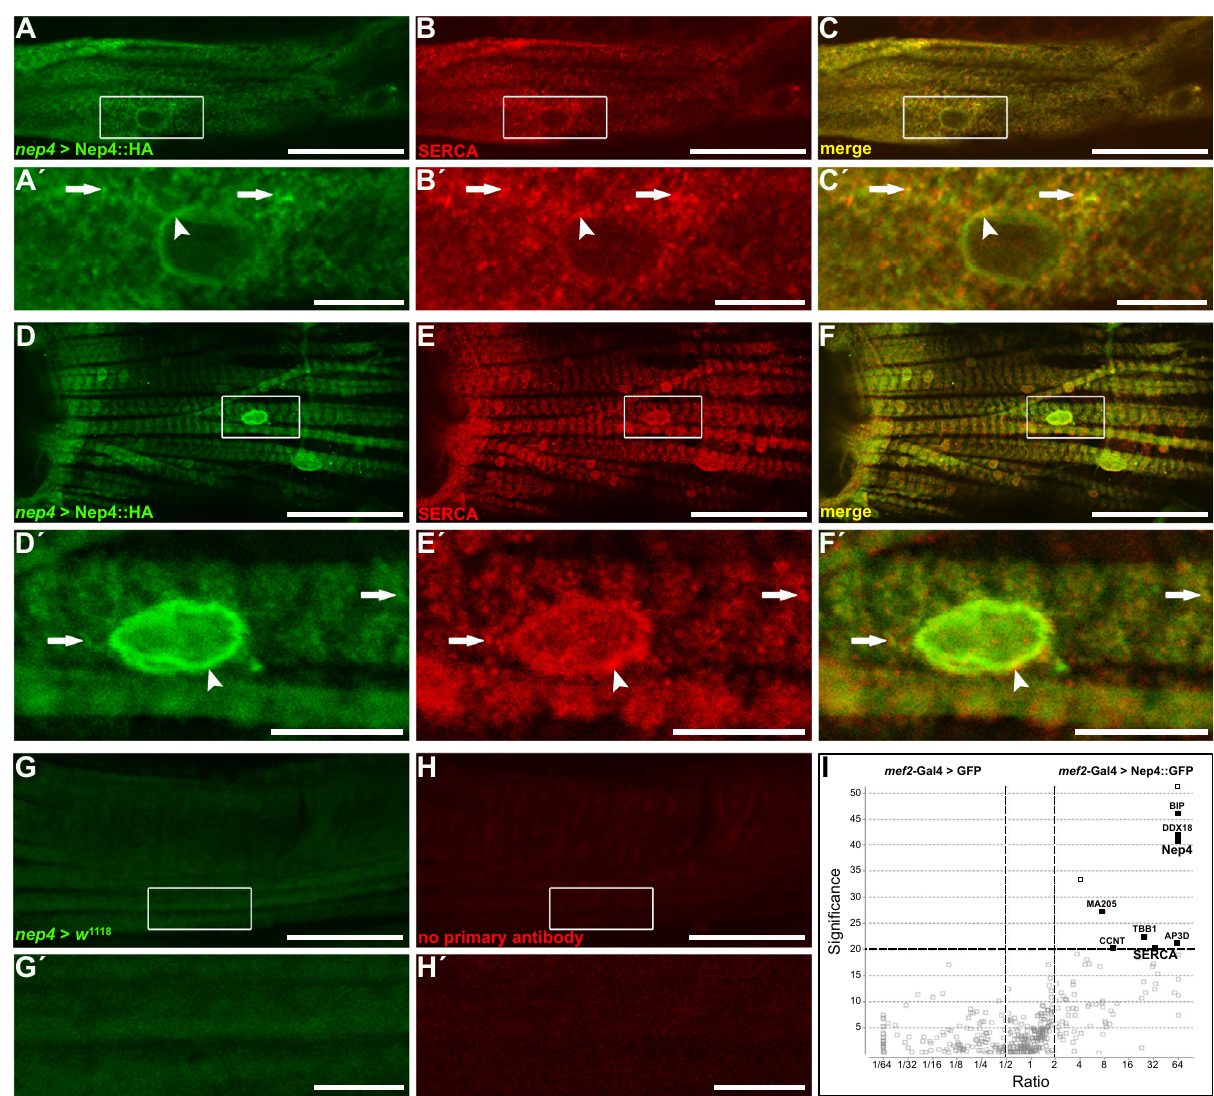
Fig.3|Nep4partiallycolocalizeswithSERCAinheart tissue.A , D Nep4::HAwas expressed under the control of the native nep4 enhancer and labeled with a